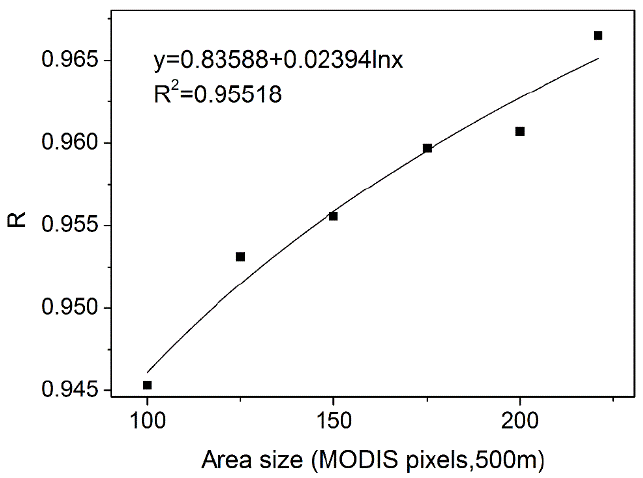
Figure 7. Relationship between correlation coefficient R and study area